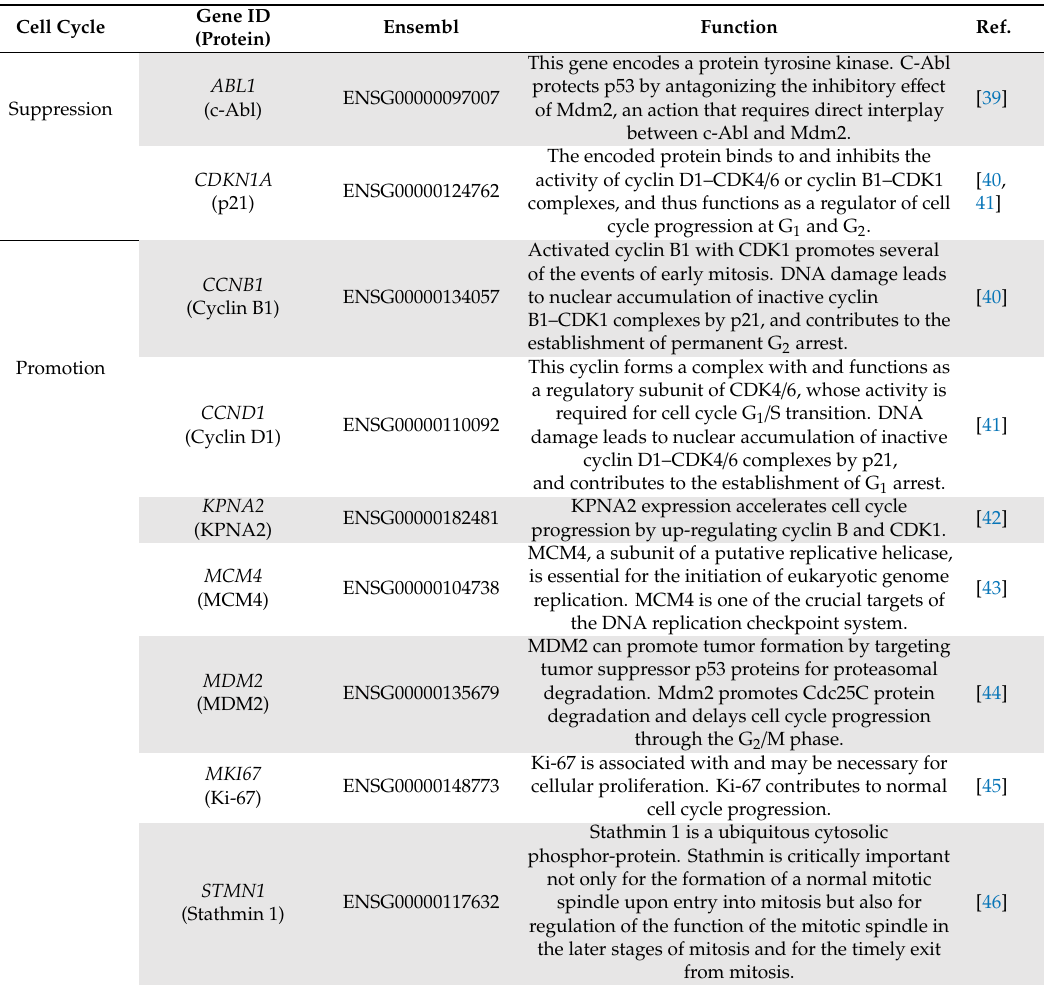
Table 2. Summary of nine cell cycle-related genes a ff ected by combined treatment with radiation and simulated µ G identified by the screening criteria shown in Figure